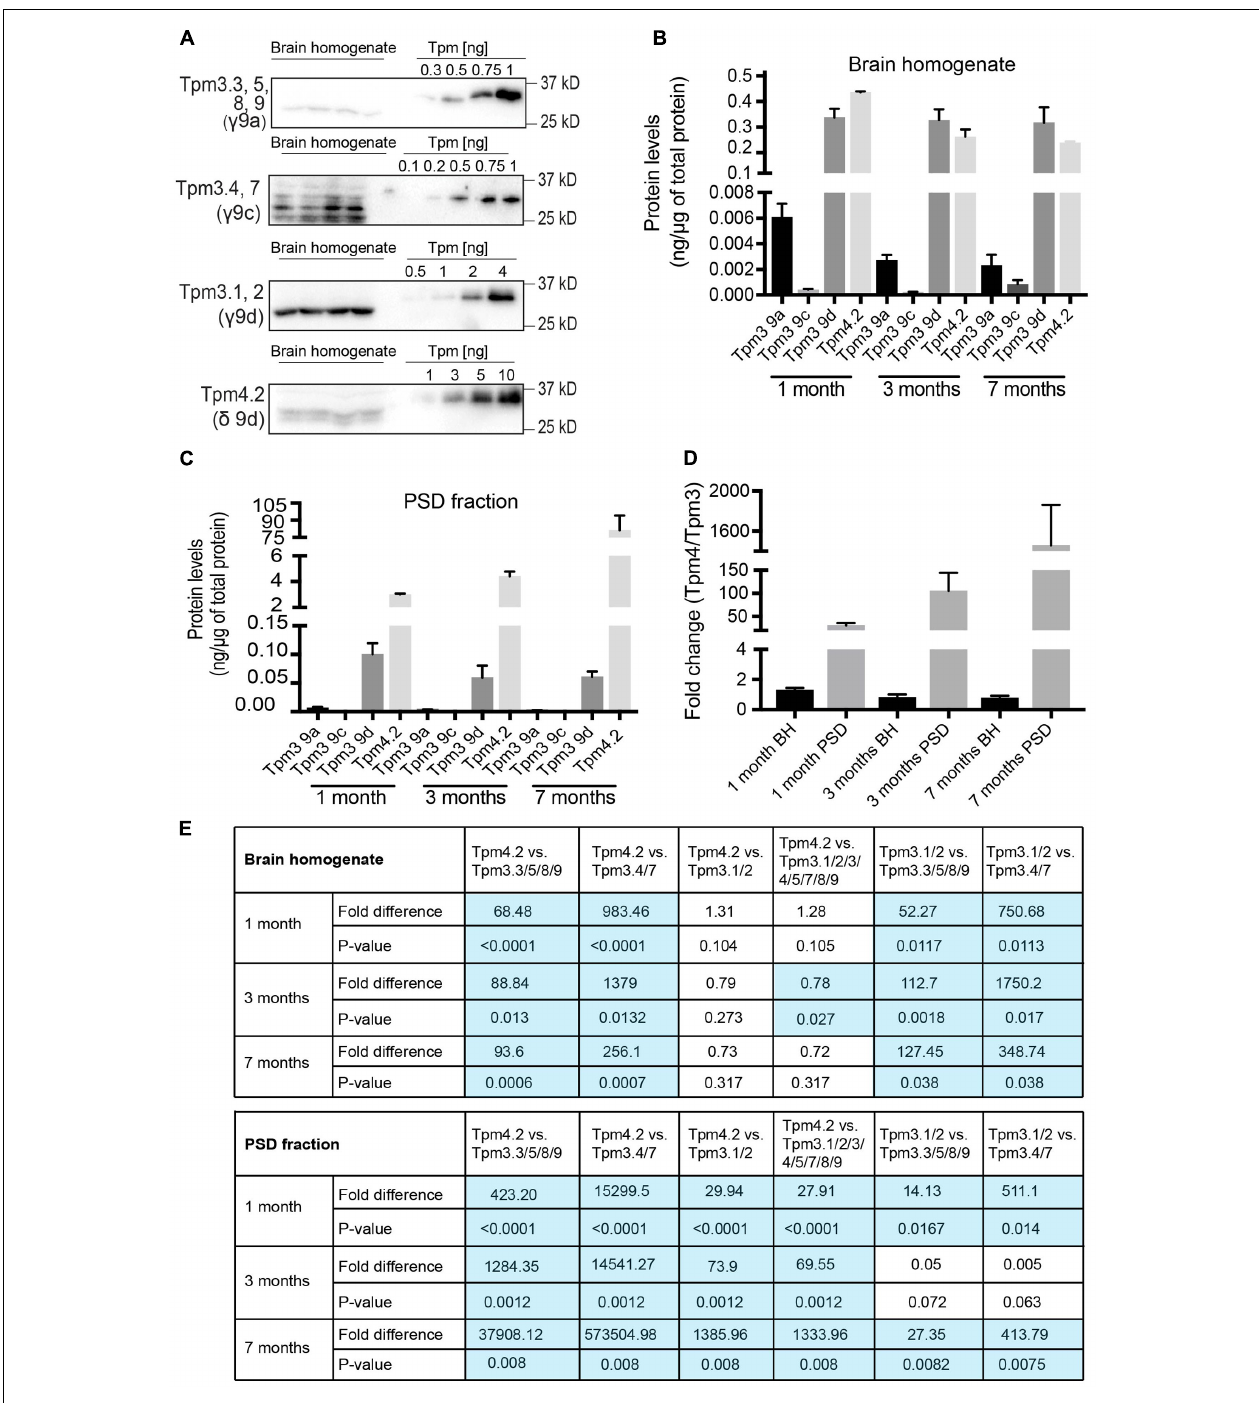
FIGURE 9 | Total protein expression of Tpm3 and Tpm4 products. (A) Western blot analysis of absolute levels of Tpm expression from Tpm3 and Tpm4 in the brain homogenate of 1-month-old mice. Note the higher molecular weight of recombinant Tpm constructs due to a His-tag. (B) Quantification of absolute levels of Tpm isoforms from Tpm3 and Tpm4 in the brain homogenate of mice. (C) Quantification of absolute levels of Tpm isoforms from Tpm3 and Tpm4 in the post-synaptic density of mice. (D) Comparative levels of the contribution of Tpm3 versus Tpm4 isoforms to the total output from Tpm3 and Tpm4 in brain homogenate (BH) and the post-synaptic density (PSD) fraction. (E) Fold difference in expression of Tpm4.2 compared to Tpm3 isoforms in brain homogenate. (I) Fold difference in expression of Tpm4.2 compared to Tpm3 isoforms in the post-synaptic density fraction. Shown are p -values comparing individual Tpm isoforms. (mean ± SEM, n = 4). Significant differences in (E) are highlighted in